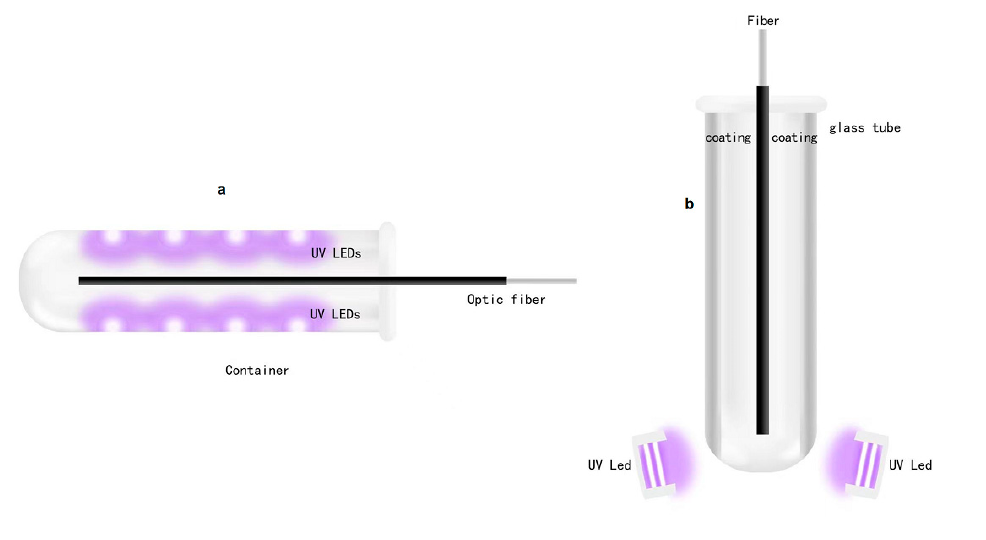
Figure 4. Preliminary design ( a ), sketch of coating ( b